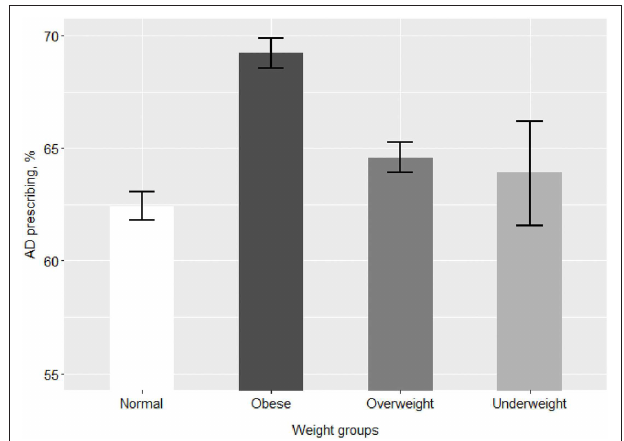
FIGURE 1 | Prevalence of prescribing at least one AD among patients of different weight groups. AD, antidepressant medications. The bars represent % prevalence and 95% confidence intervals of prescribing at least one AD for patients of each weight